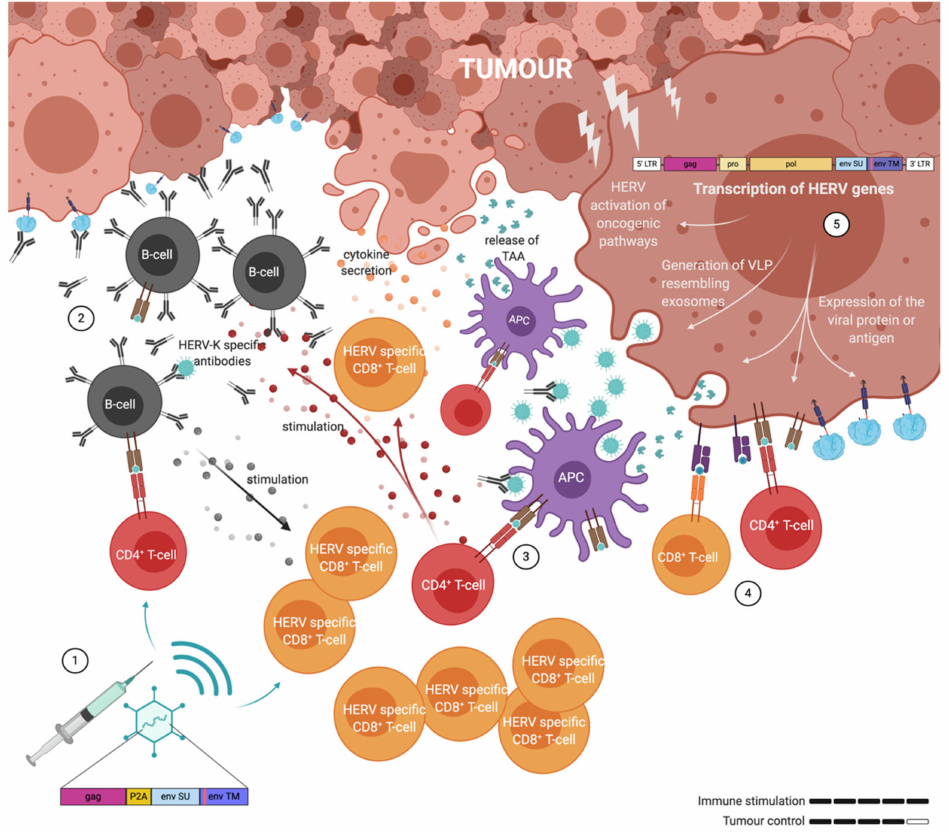
Figure 4. Illustration of the immune response elicited by adenovirus associated virus-like-vaccine (VLV) vaccination against human endogenous retrovirus (HERV) antigens presented and released by the tumour cells. (1) Immunisation has given rise to ERV specific B-cells, CD4 + T-cells and CD8 + T-cells. (2) B-cell derived antibodies bind cancer cells in order to block ERV immune suppression and facilitate antigen uptake and presentation on the surface of antigen presenting cells (APCs). (3) Vaccine induced CD4 + T-cells are activated by the antigen-MHCII complex presented on the surface of APC’s and stimulate other tumour infiltrating immune cells: B-cells and CD8 + T-cells. (4) Both CD4 + and CD8 + T-cells can directly contribute to tumour cell killing. (5) ERV genes are transcribed in cancer cells and not only contribute to oncogenesis, but also in the release of exosomes and the presentation of antigens on the surface of cancer